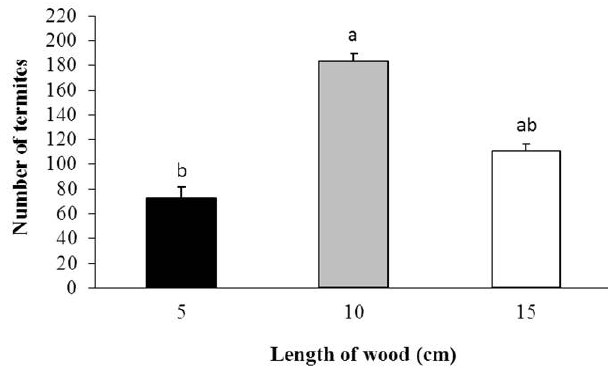
Fig 2 . Number of termites of Nasutitermes corniger recruited (average ± SD) after 60 minutes of the test (n = 20) of three lengths of Eucalyptus grandis wood: 1) 5.0 x 2.5 x 2.0 cm (Size 1); 2) 10.0 x 2.5 x 2.0 cm (Size 2); and 3) 15.0 x 2.5 x 2.0 cm (Size 3). Different letters indicate a significant difference between the treatments based on Tukey’s HSD test, p < 0.05.